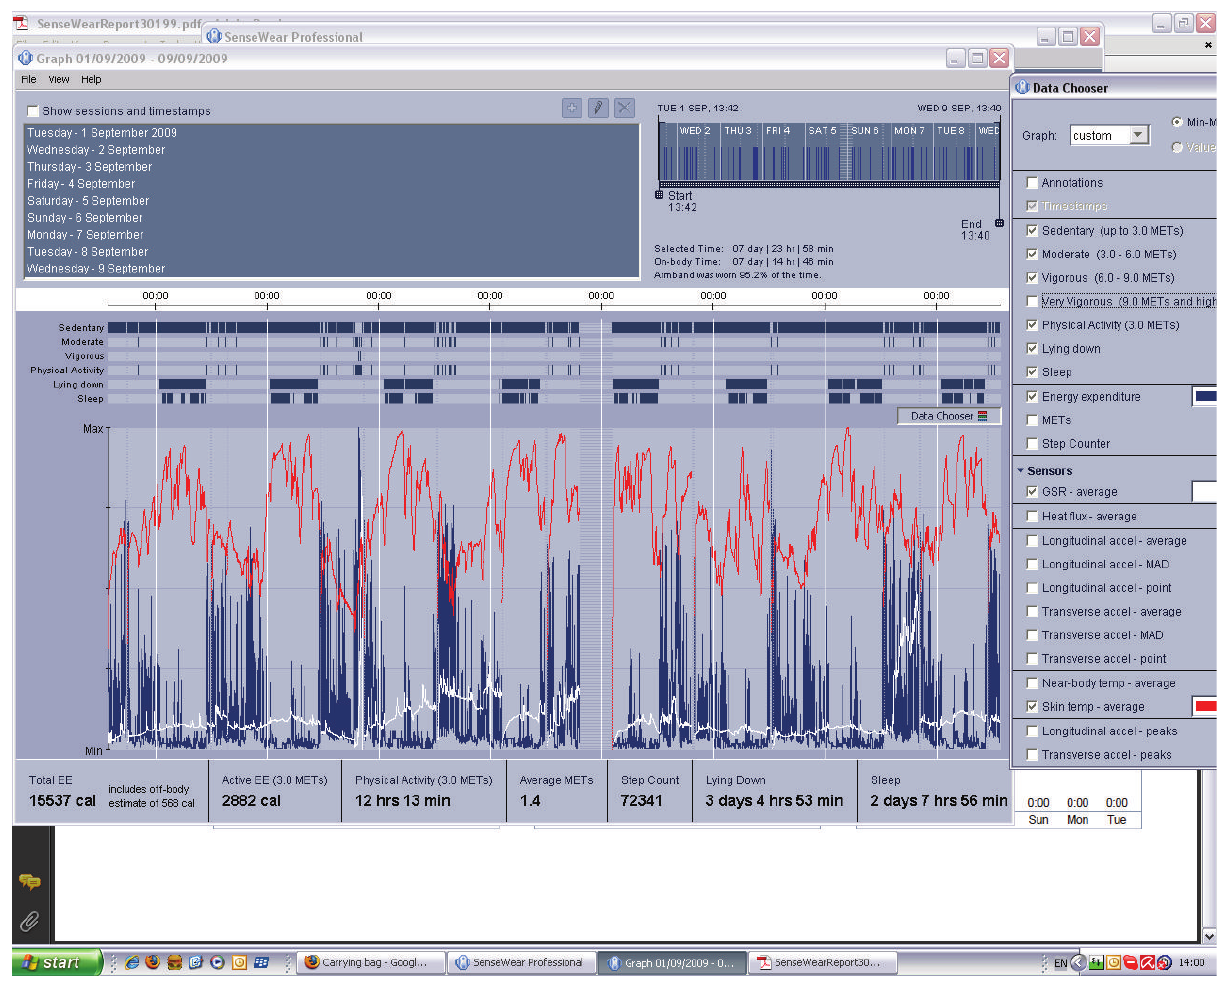
Figure 7: Pattern over the whole 8